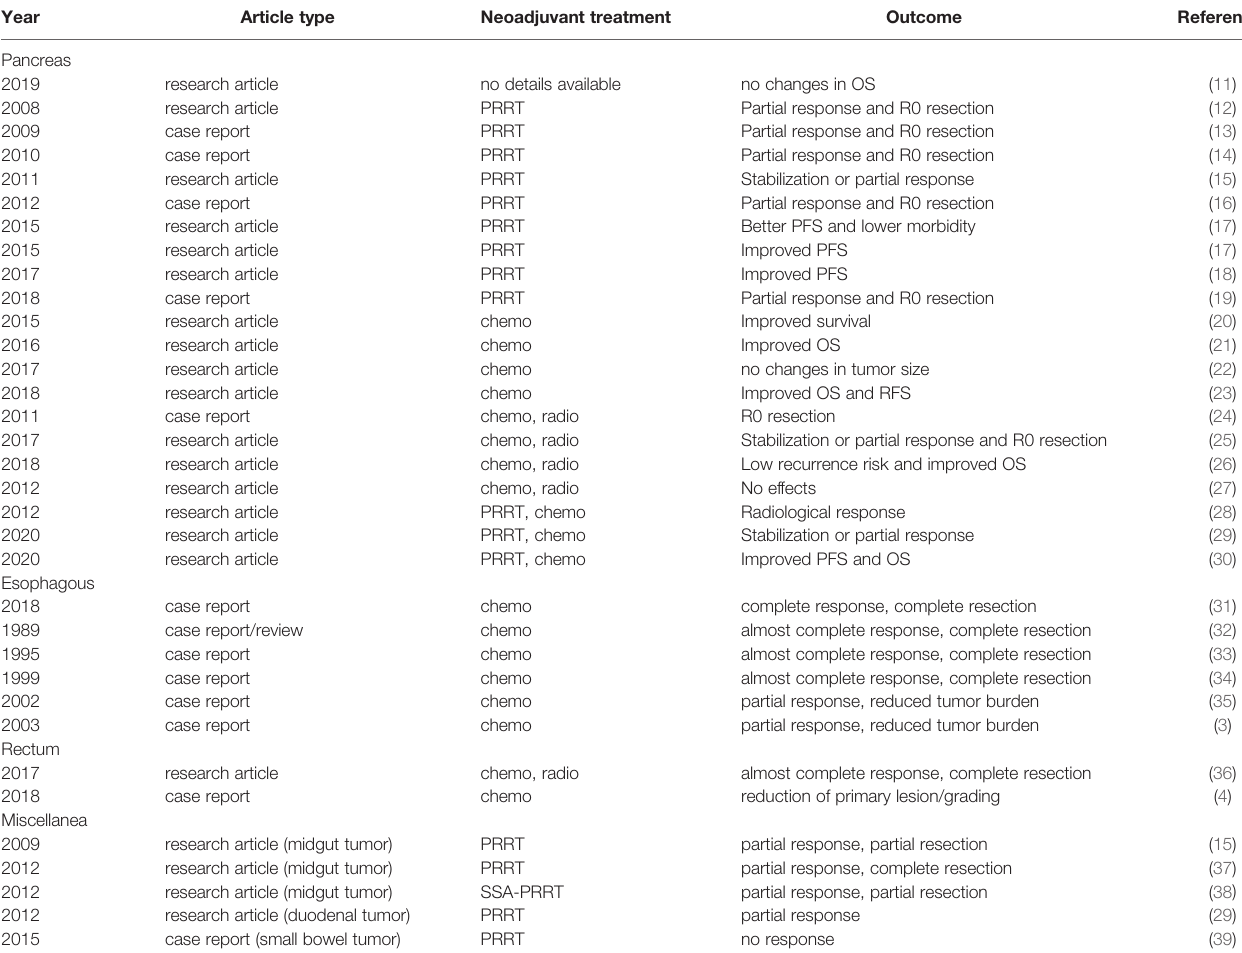
TABLE 1 | Neoadjuvant therapies in gastroenteropancreatic